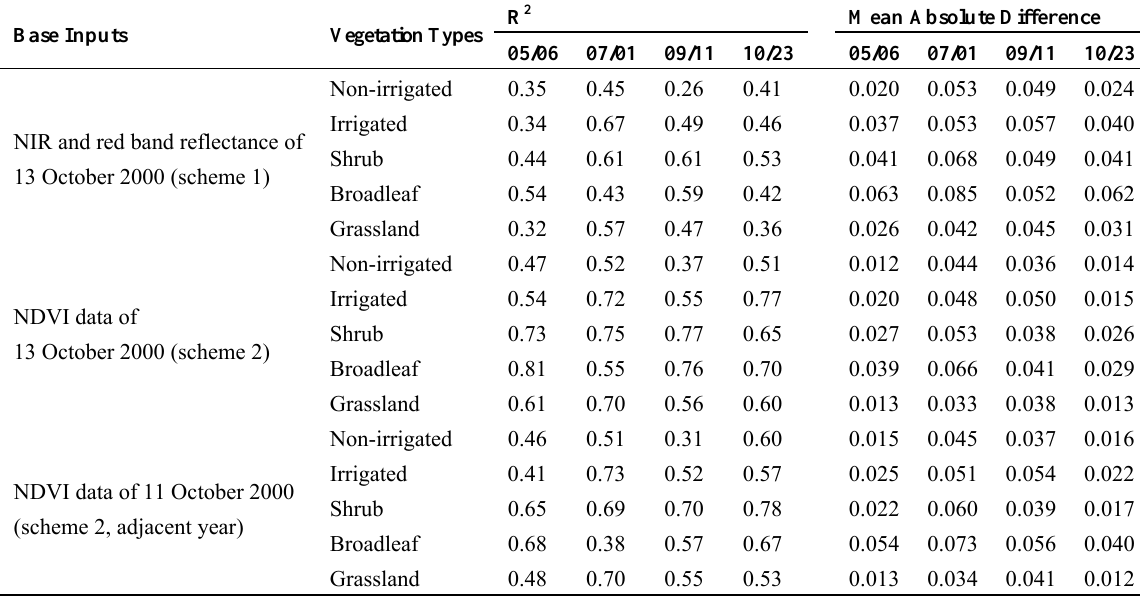
Table 2. R 2 and mean absolute difference among different vegetation types between Landsat NDVI images of 6 May 2000, 1 July 2000, 11 September 2000 and 21 October 2000 and the corresponding synthetic NDVI images, with base pair images of NIR and red band reflectance of 13 October 2000 (scheme 1), NDVI data of 13 October 2000 (scheme 2) and NDVI data of 11 October 2002 (scheme 2, adjacent